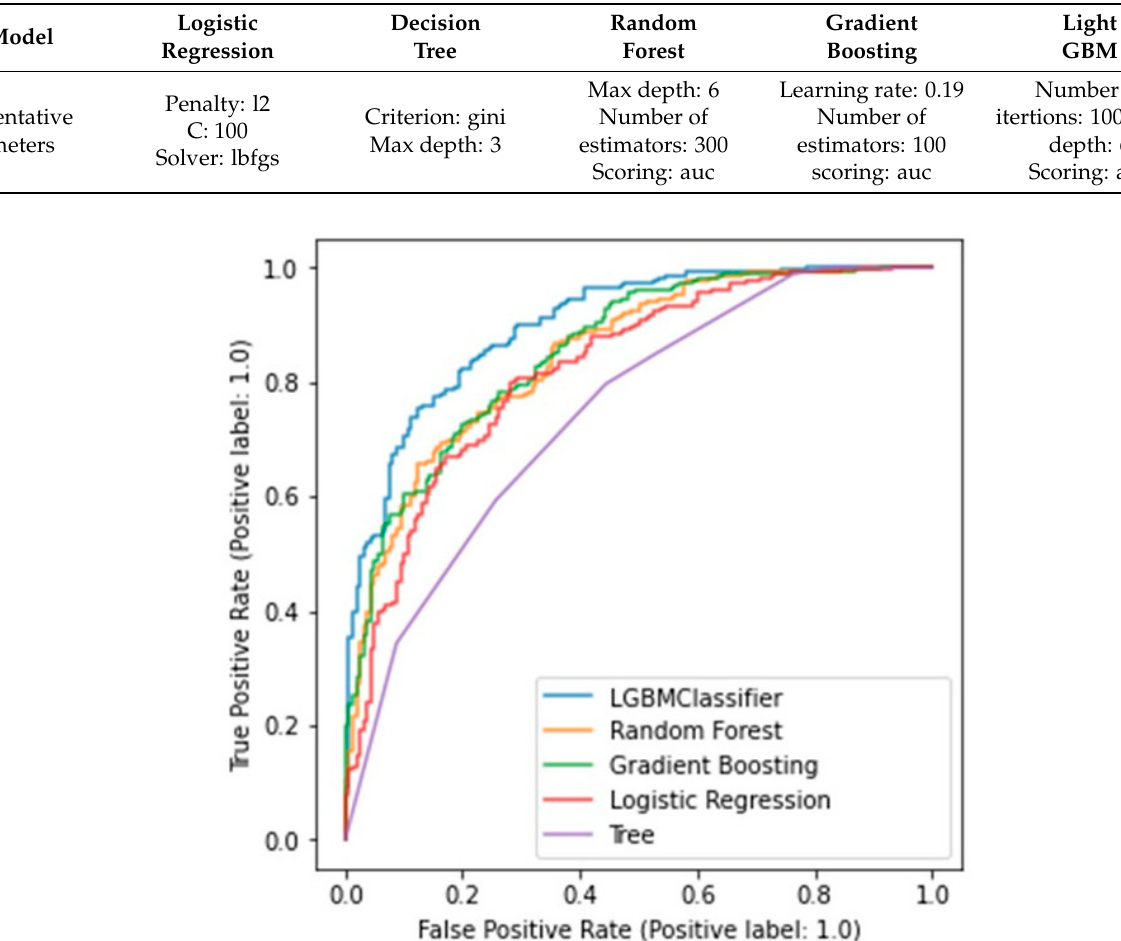
Table 5. Summary of hyperparameters of each model. (lbfgs: limited-memory Broyden–Fletcher– Goldfarb–Shanno; auc: area under the curve).